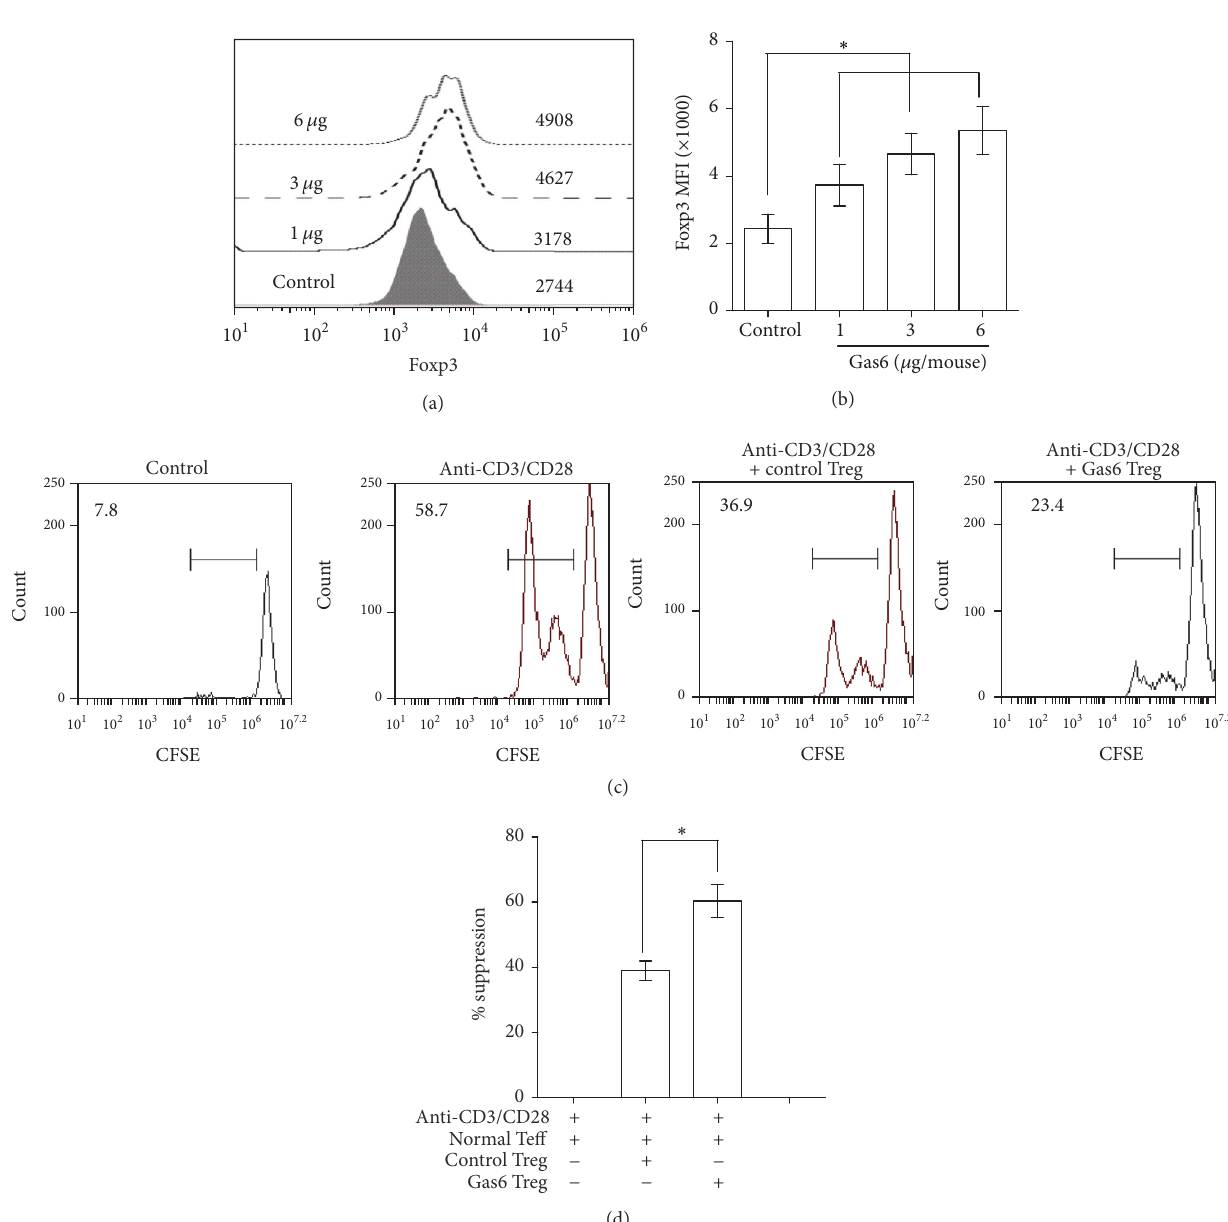
Figure 3: CD4 + CD25 + Tregs from rmGas6-treated mice exhibited increased Foxp3 levels and suppressive activity. BALB/c mice were administrated with 1, 3, or 6 𝜇 g/mouse of rmGas6 via tail vein. After 24 hours, CD4 + CD25 + T cells were purified from spleens. (a-b) MFI analyses showing expression levels of Foxp3 protein in CD4 + CD25 + T cells from rmGas6-treated mice and control mice (two mice each in two independent experiments). ∗ 𝑃 < 0.05 compared with the value for the control group. (c) CD4 + CD25 − T cells from normal mice were cocultured with CD4 + CD25 + T cells from control or Gas6-treated mice for 3 days with or without anti-CD3 and anti-CD28 stimulation (three mice each in two independent experiments). Histogram of CFSE-labeled CD4 + CD25 − T cells are displayed, and the percentage of cells that have proliferated as shown in gates. One representative example is shown. (d) Mean percentage of suppression was calculated ( 𝑛 = 6 ). CD4 + CD25 + T cells from Gas6-treated mice had increased suppressive activity when compared with those from control mice. ∗ 𝑃 < 0.05 compared with the value for anti-CD3/CD28